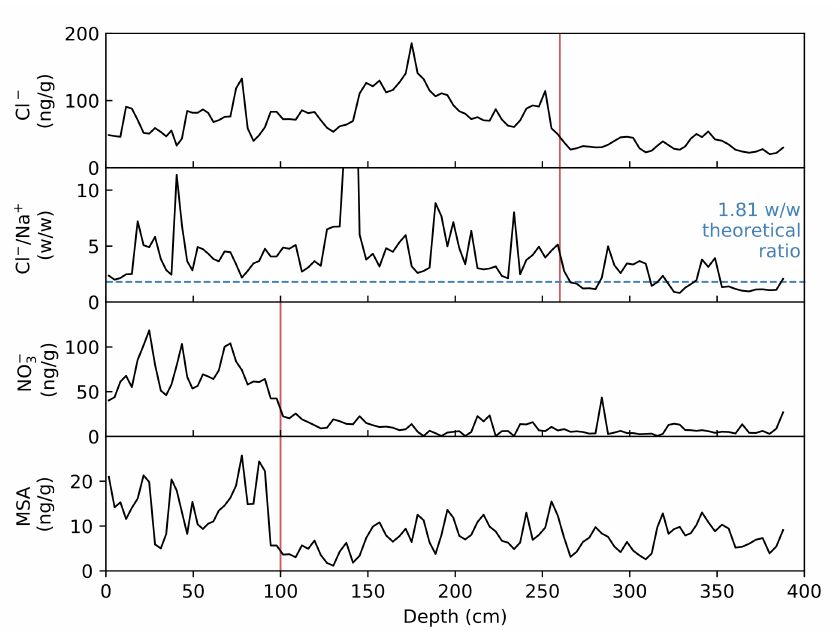
Figure 5. Concentration vs. depth of profile of the ions involved in post-depositional processes: Cl − , NO 3 − and MSA, and Cl − /Na + ratio. The red vertical lines show the threshold of the post- depositional processes for the four